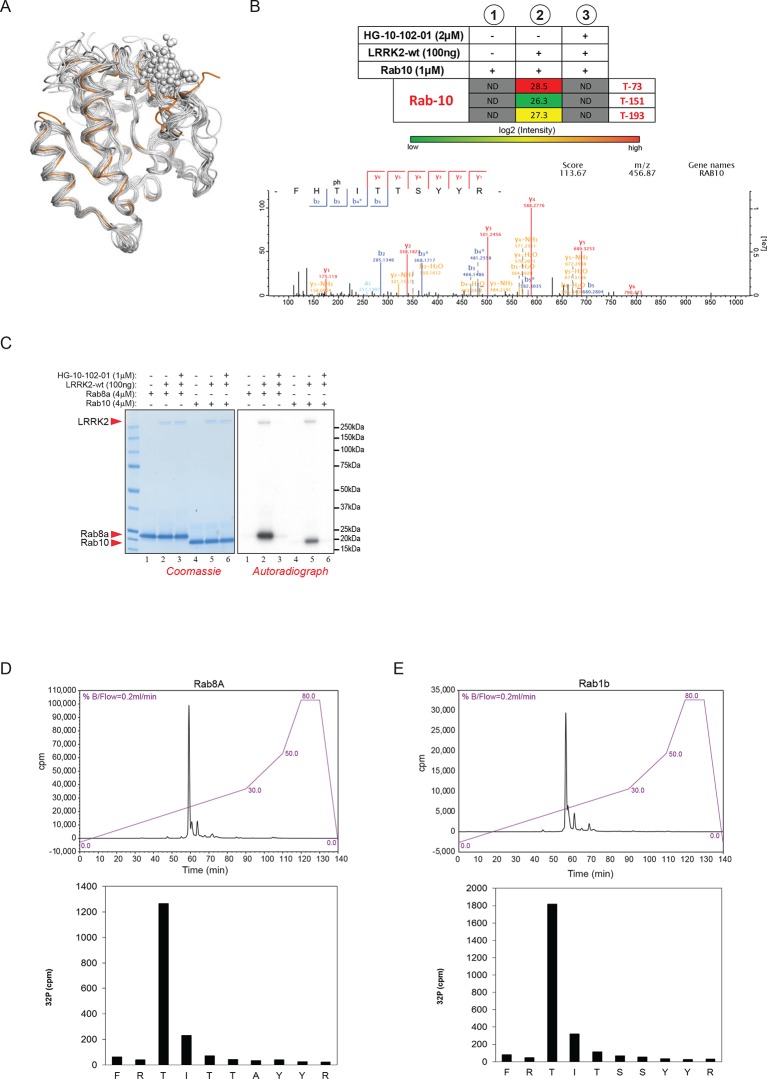
Phosphorylation of Rab GTPases by LRRK2 in vitro.(A) Superposition of the crystal structures of 14 Rab isoforms (Rab1a, 1b, 2, 3, 4, 6, 7, 9, 12, 18, 27, 30, 31, 43). All potential LRRK2 phosphorylation sites (in grey) cluster in the same region. (B) MS analysis of in vitro phosphorylated Rab10 identified three LRRK2-specific sites (note that phosphorylation is prevented completely by HG-10-102-01) and pT73 as the one with the highest intensity. The collosion-induced dissociation (CID) fragmentation spectrum and the Andromeda score (score) (Cox et al., 2011 ) for the tryptic pT73-Rab10 peptide are shown. (C) Phosphorylation of Rab8a and Rab1b by LRRK2-wt. Inhibition of LRRK2 by HG-10-102-01 prevents phosphorylation. (D) HPLC trace of tryptic peptides of Rab8a and Rab1b (E) after in vitro phosphorylation by LRRK2-wt and sequence analysis of tryptic peptides. Y axis units are relative Cherenkov counts per minute. MS, mass spectrometry; wt, wild type.